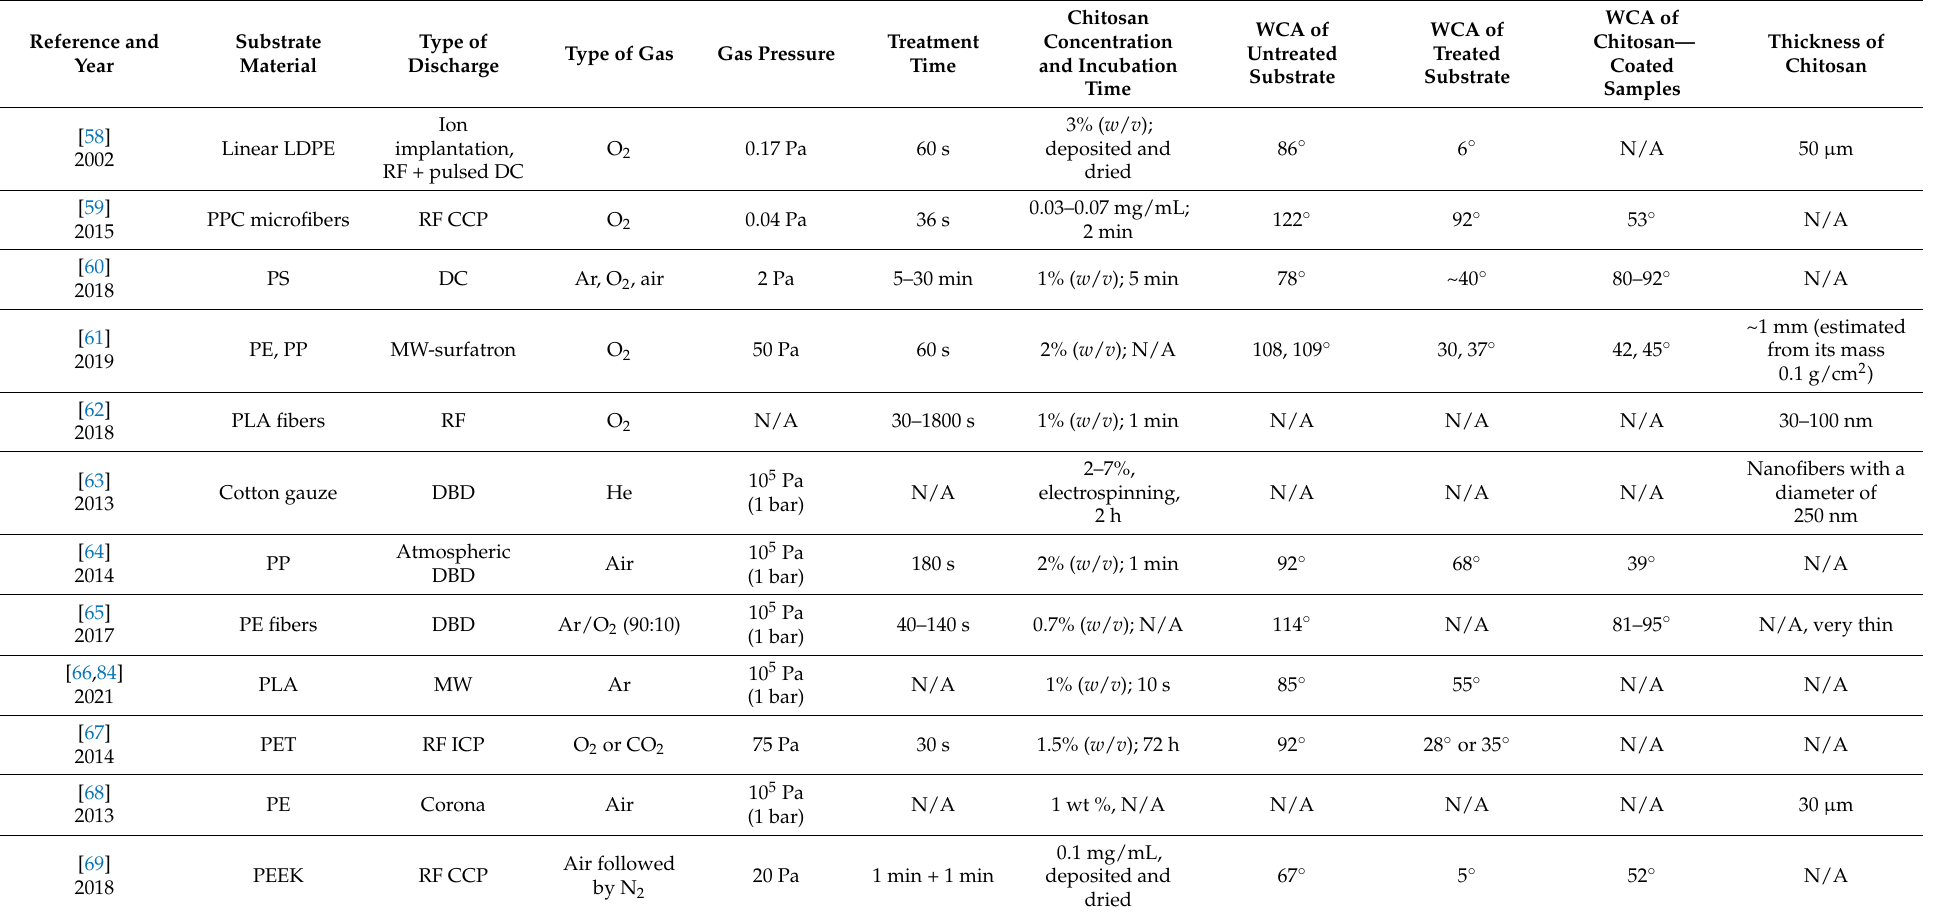
Table 1. Summary of processing parameters and surface finish reported for direct chitosan immobilization on plasma-treated substrates. Abbreviations in the table are defined in the notes